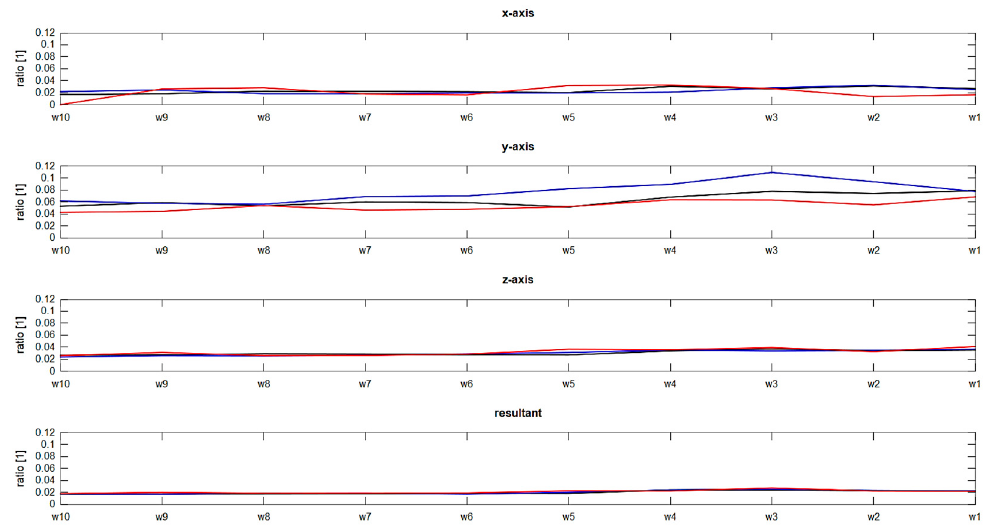
Figure 5. Median values of the CV for the three axes and the resultant acceleration of the bow arm. Every graph contains the values for C1 (black), C2 (blue) and C3 (red).